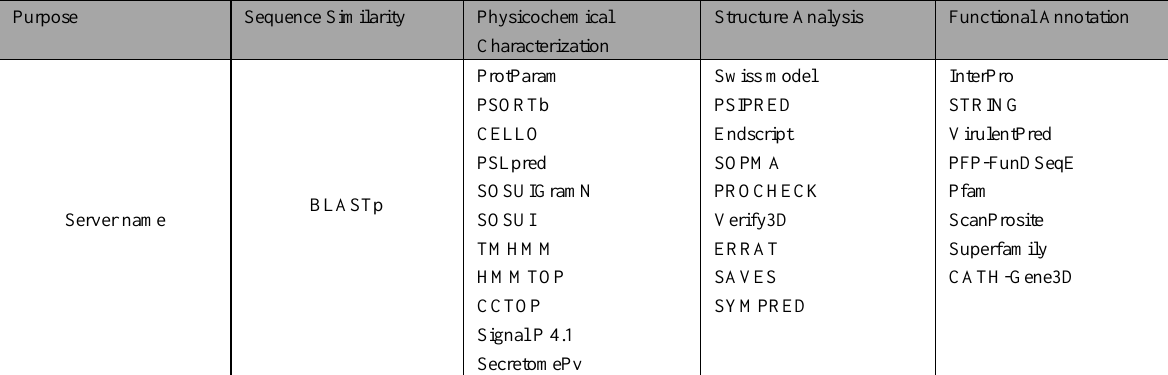
Table 1. The complete layout demonstrates all the tools used for structural and functional annotation of the protein